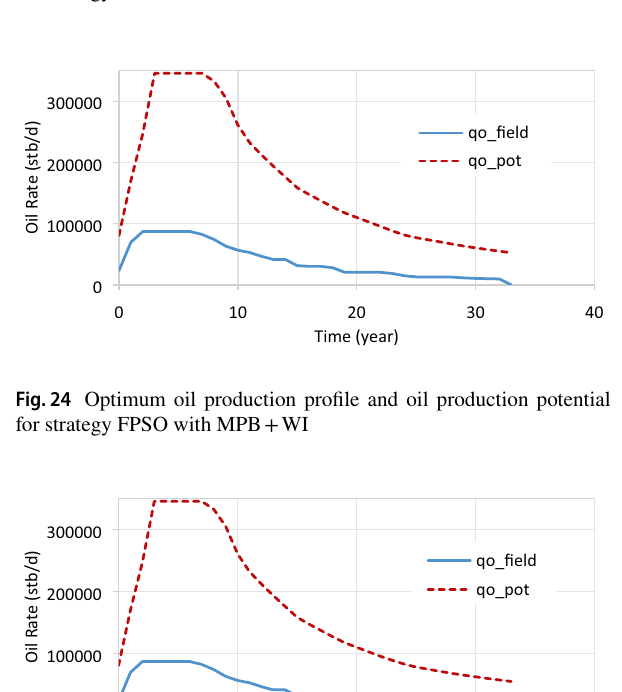
Fig. 23 Optimum oil production profile and oil production potential for strategy TLP with MPB + WI